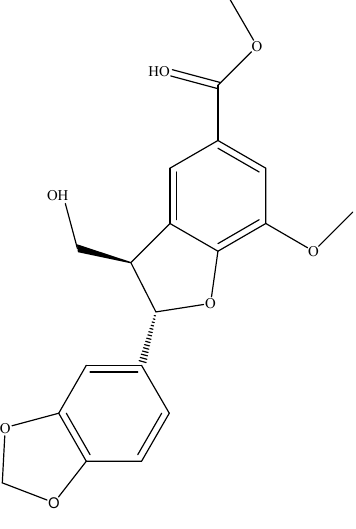
Figure 2. Structure of toonin